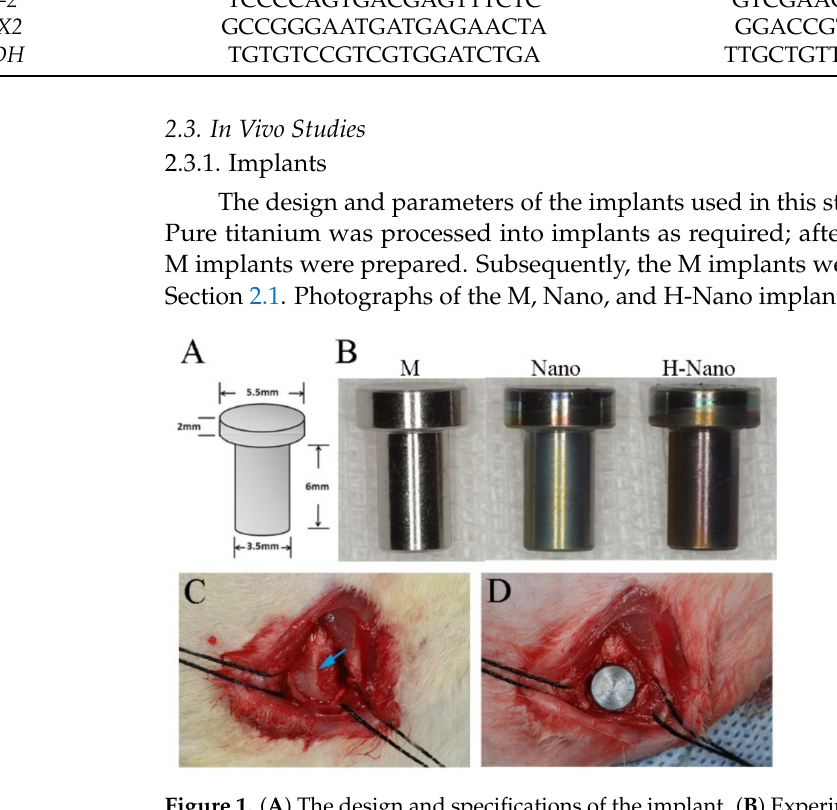
Figure 1. ( A ) The design and specifications of the implant. ( B ) Experimental implants of three groups: machined polished implant (M), anode oxidized implant with nanotubes (Nano), and hydrogenated implant (H-Nano). ( C ) Implantation site. Blue arrow: the distal metaphysis of the femoral